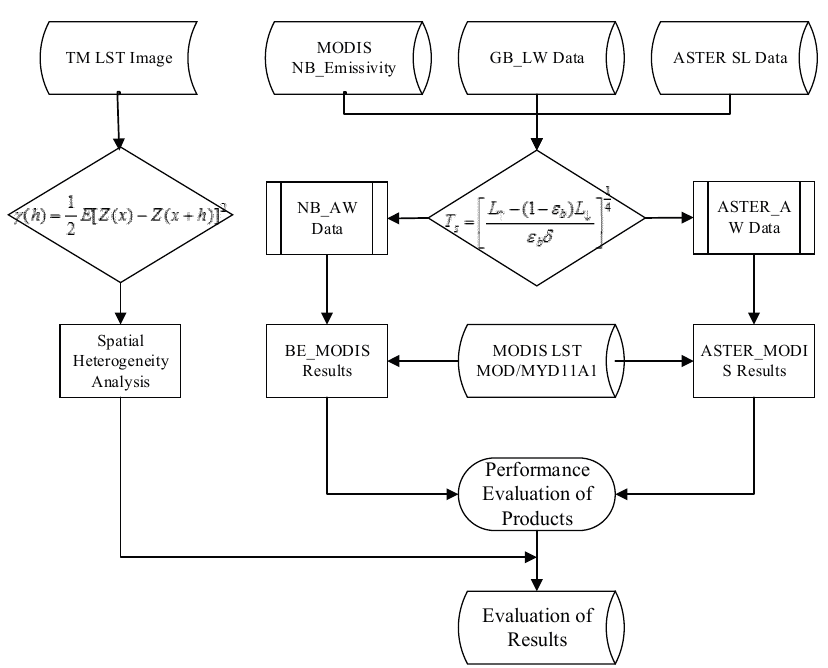
Figure 2. The flowchart of the study. “MODIS NB_Emissivity” is for the MODIS narrowband emissivity products retrieved by the day/night algorithm. “GB_LW Data” is the ground-based longwave radiation data. “ASTER SL Data” is the ASTER spectral library data. “NB_AW Data” is the ground-based LST obtained from “GB_LW Data” and the broadband emissivity retrieved based on “MODIS NB_Emissivity”. “ASTER_AW Data” is the ground-based LST retrieved from “GB_LW Data” and broadband emissivity from the “ASTER SL Data”. “BE_MODIS Results” is a comparison of results between the “NB_AW Data” and “MODIS LST MOD/MYD11A1”. “ASTER_MODIS Results” is a comparison of results between the “ASTER_AW Data” and “MODIS LST